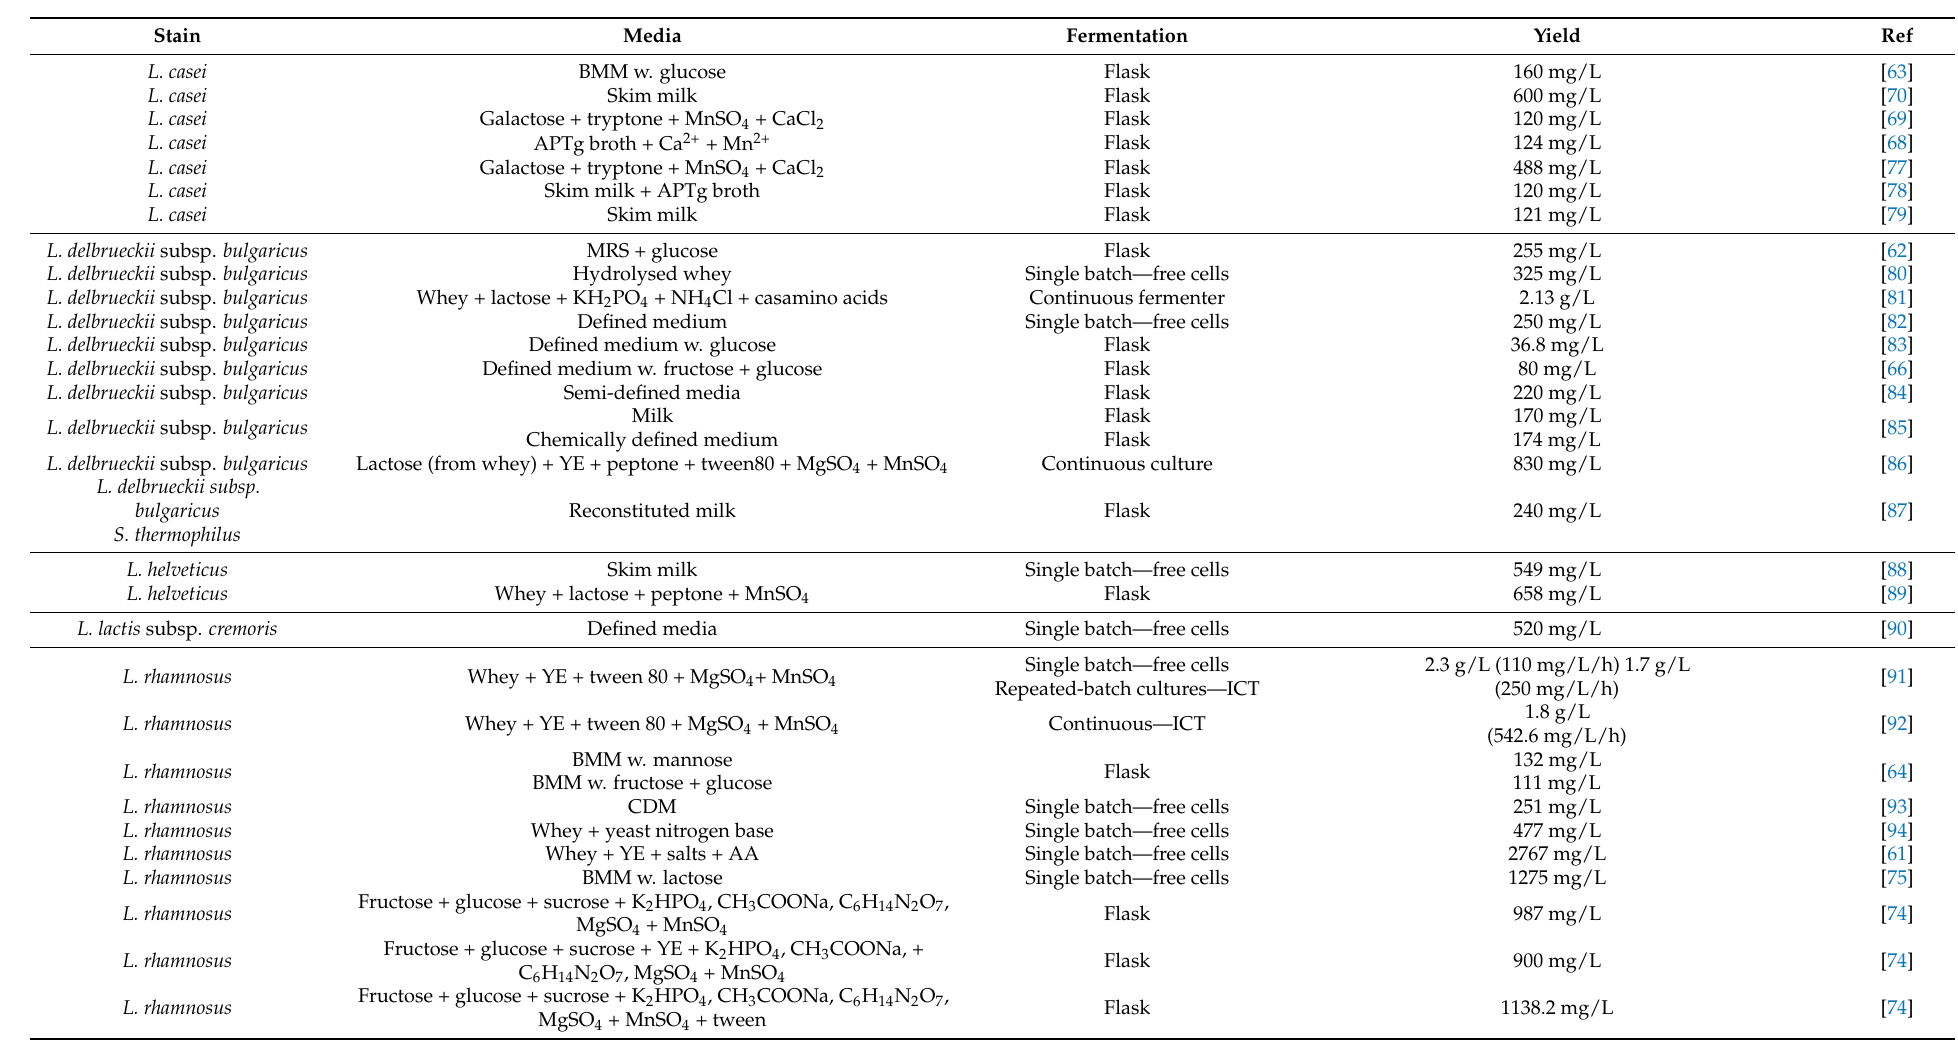
Table 1. Summary of EPS-producing strains and